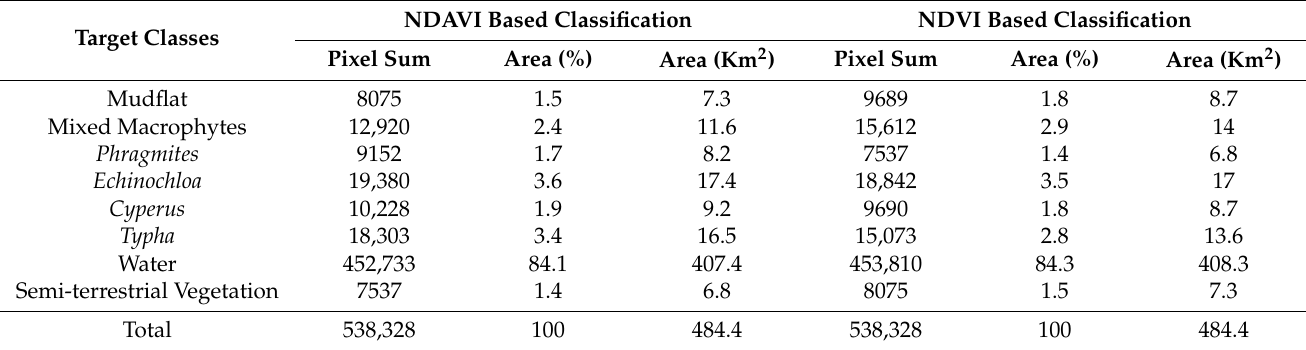
Table 2. Distribution of dominant emergent macrophytes and other target classes from Lake Ziway and the surrounding based on Normalized Difference Aquatic Vegetation Index (NDAVI) and NDVI classification inputs.